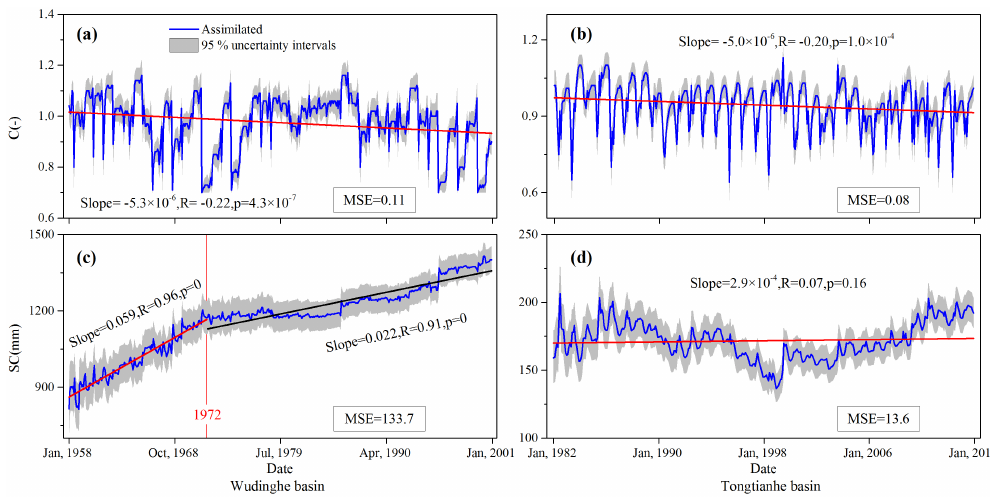
Figure 7. Estimated parameter values of C and SC for (1) Wudinghe basin within the period of 1958–2000, and (2) Tongtianhe basin within the period of 1982–2013. The gray areas represent the 95% prediction uncertainty intervals. Note that the MSE denotes the standard deviation of the estimated parameter values.